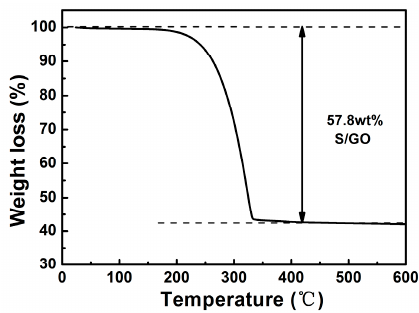
Figure 2. TGA curve of S/GO composite at a heating rate of 10 °C min − 1 .